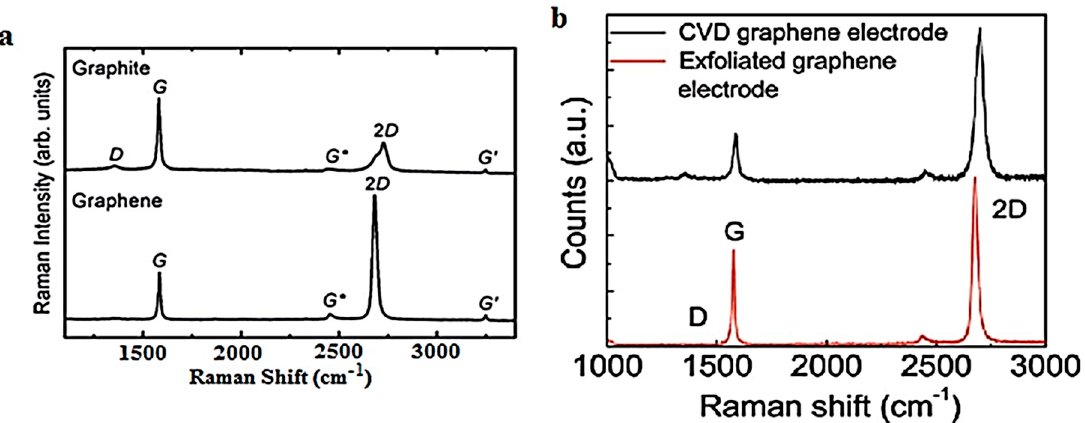
Figure 2. ( a , b ) Raman spectra of Gr and Gp. Reprinted with permission from [60]. Copyright RSC Publishers, 2017.